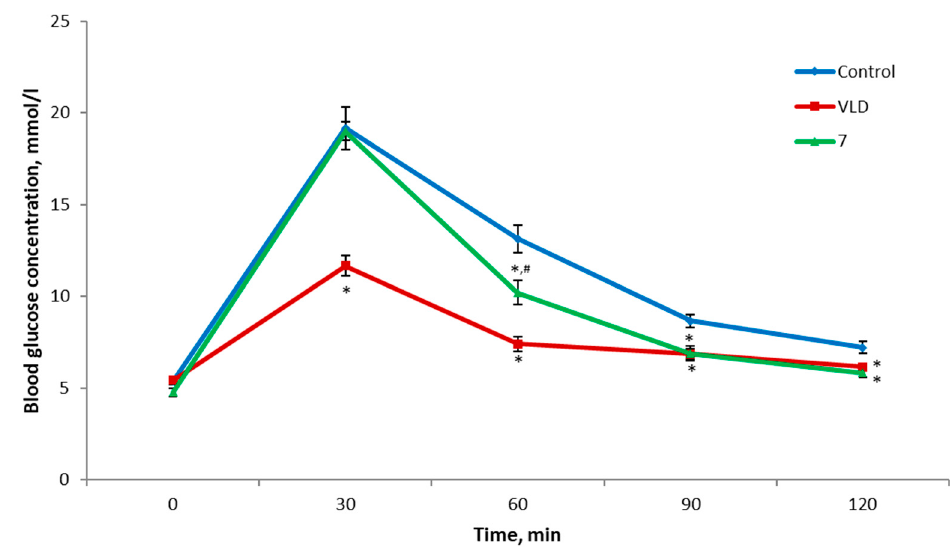
Figure 2. Results of the OGTT (mice n = 6 in each group). * p < 0.05 compared to the control, # p < 0.05 as compared to the VLD 10 mg/kg. VLD—vildagliptin.